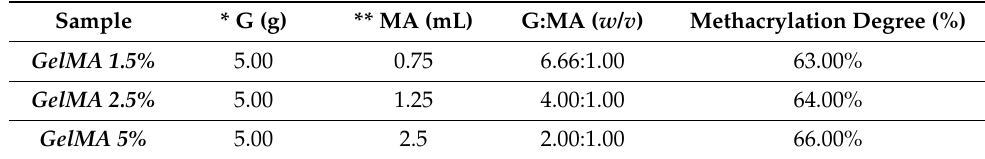
Table 1. GelMA composition and methacrylation